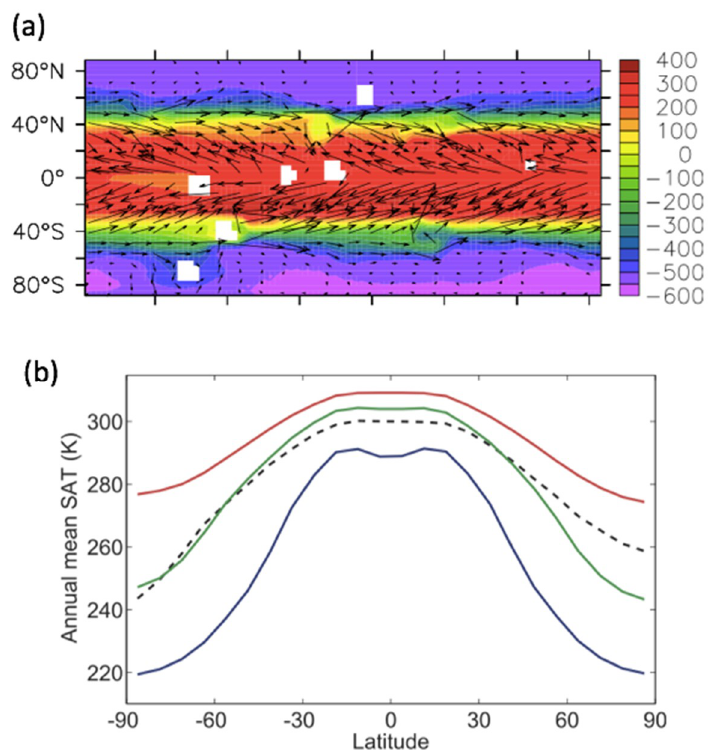
Figure 17. ( a ) Sketch of Keinert et al.’s [101] model of ocean currents during the Archean. Oceanic surface velocities are indicated by the arrows and colour shading indicates sea surface height anomalies. The white squares represent small continents. ( b ) Annual and zonal mean surface air temperature (SAT) for the pre-industrial Earth (black), the critical state of the early Archean (pCO 2 = 0.4 bar, blue), the state of the early Archean with present-day mean SAT of 288 K (pCO 2 = 0.6 bar, green) and an ice-free state (CO 2 = 0.8 bar, red) [101].